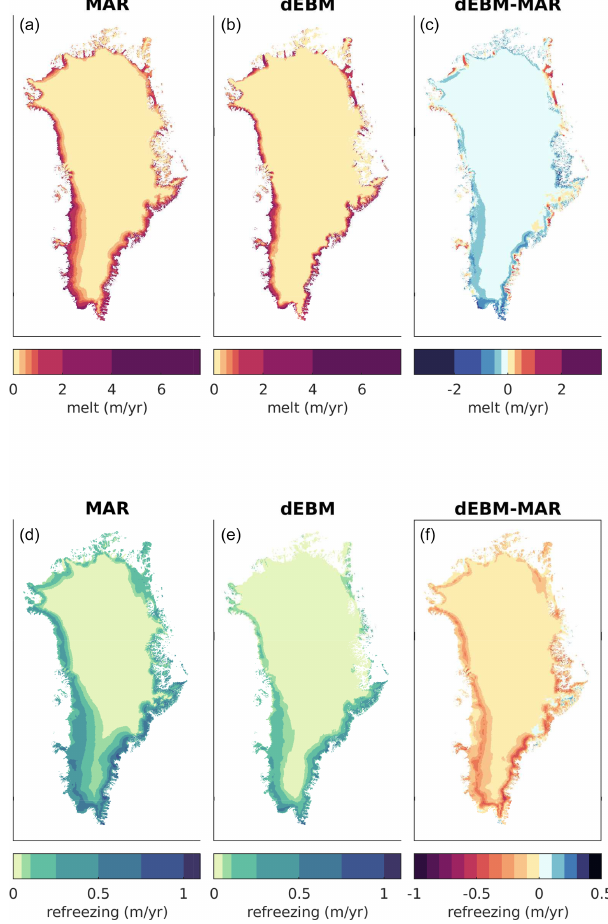
Figure 9. Comparison of multi-year (1980–1999) mean melt rates (a, b, c) and refreezing rates (d, e, f) from experiments MAR ERA (a, d) and dEBM MAR , ERA (b, e) and differences between dEBM MAR , ERA and MAR ERA (c, f)